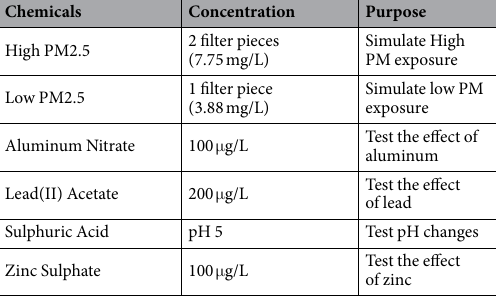
Table 1. Summary of the chemicals used in each treatment. There were 6 treatments in this experiment plus a control; two levels of PM2.5 (low and high), three different metals (Al, Pb, Zn), and one level of acidity (pH =